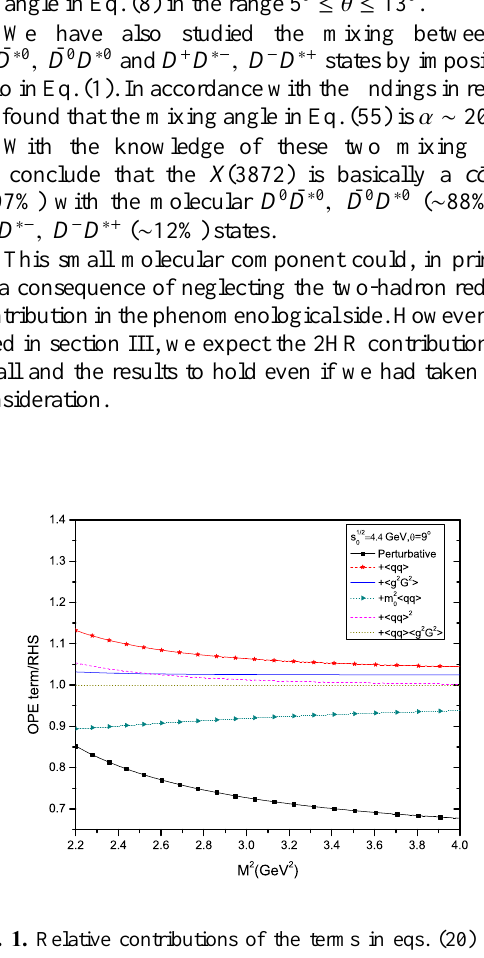
Fig. 1. Relative contributions of the terms in eqs. (20) to (30) grouped by condensate dimensions. We start with the perturbative contribution and each subsequent line represents the addition of one extra condensate in the expansion.